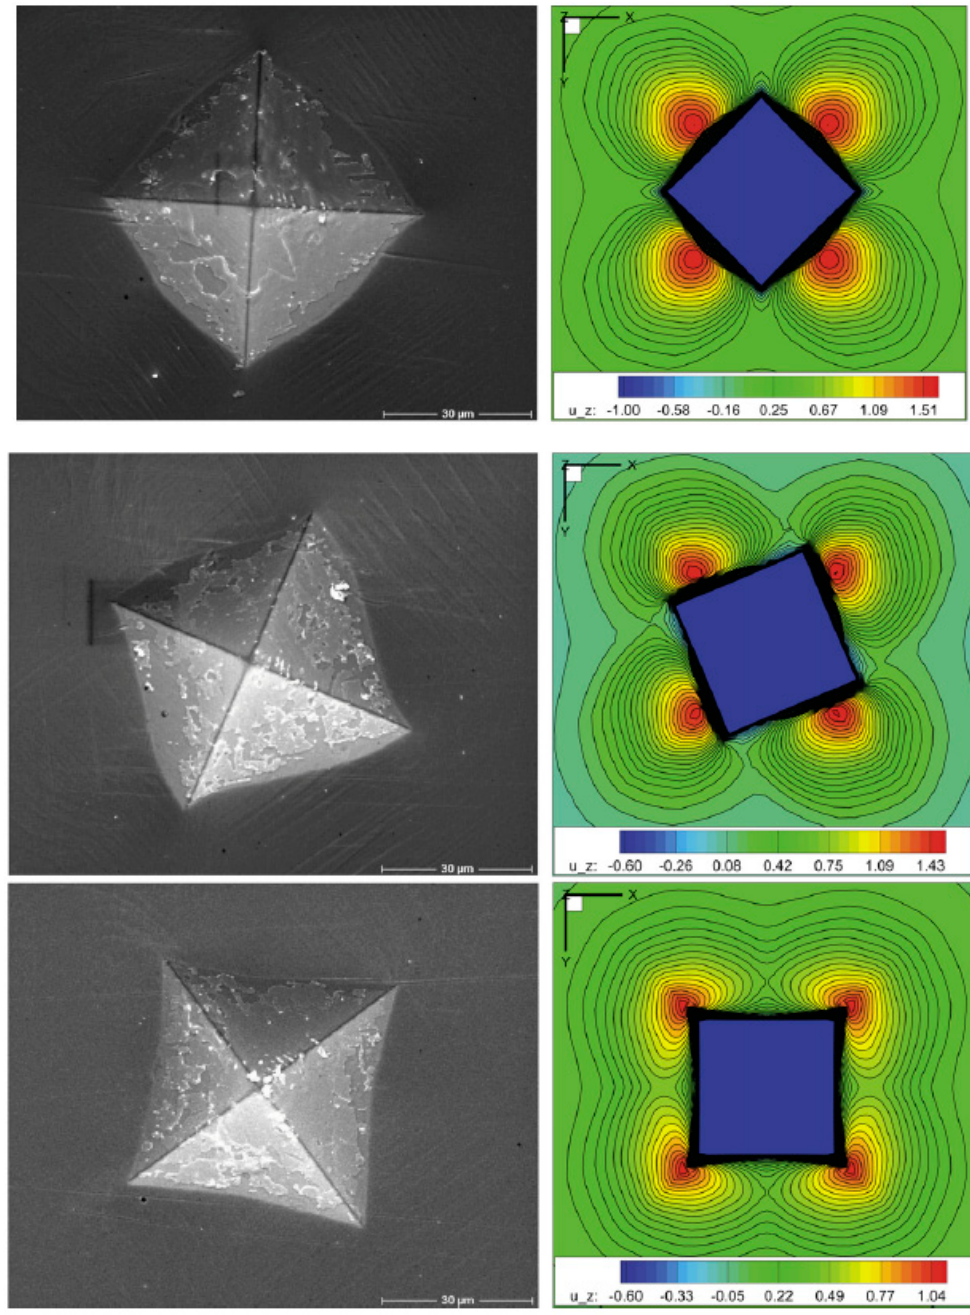
Figure 38. Pyramidal indentation experiments into (001) FCC CMSX-4. Left: experiment (SEM); right: simulation with isolines of height, uz ( μ m), for azimuthal orientation angle θ = 0°, 22.5°, 45° in row 1–3. In the coordinate system, X -, Y -, Z -axes each represent h001i directions. The white stains in the experimental indentation craters are debris from sputtering [135]. Reproduced with permission from Y. Liu et al., International Journal of Plasticity; published by Elsevier,